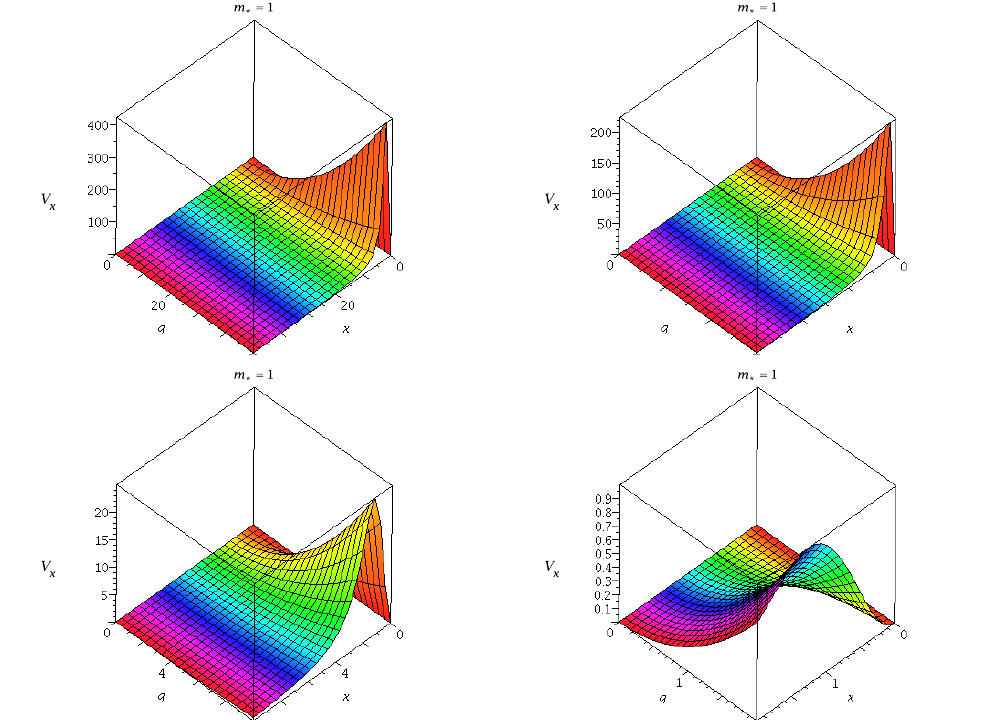
Figure 7. The figure depicts the variation of V x with x and q for ABG BH.